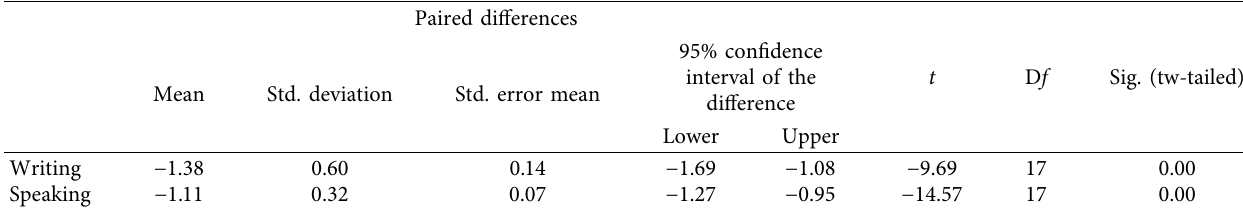
Table 4: Paired-samples t -test comparing the pretest and posttest scores of the HPBL learners.